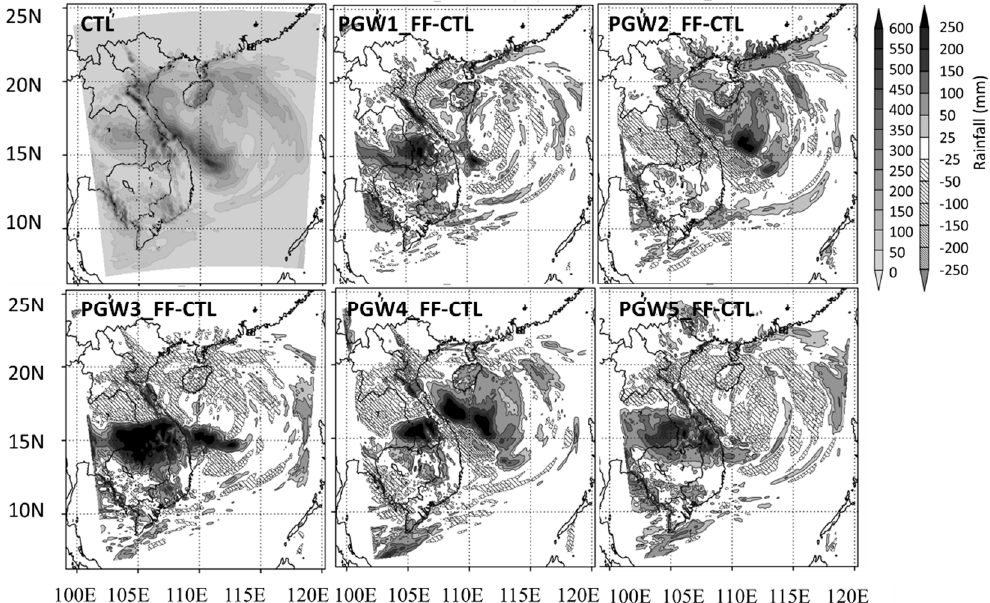
Figure 11. The average total rainfall spatial distribution of nineteen ensemble members of the CTL run, and the different spatial distribution of total rainfall between PGW_FF experiments and the CTL run.